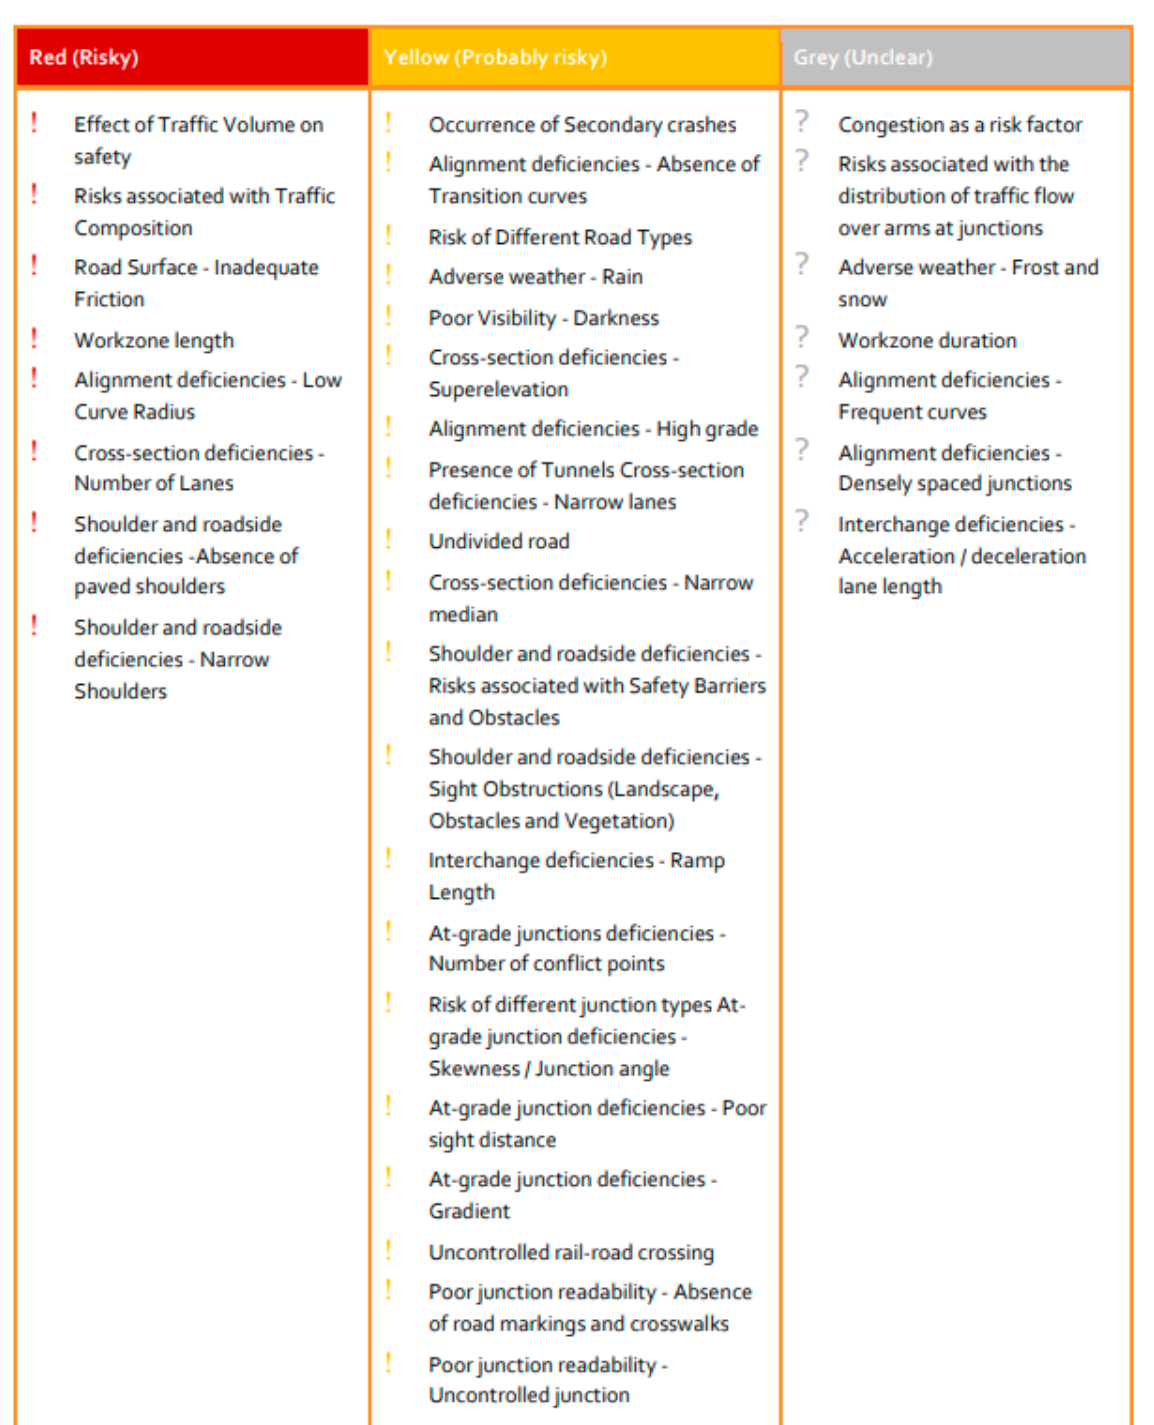
Figure 1. Infrastructure related risk factors synopses by colored code [32].